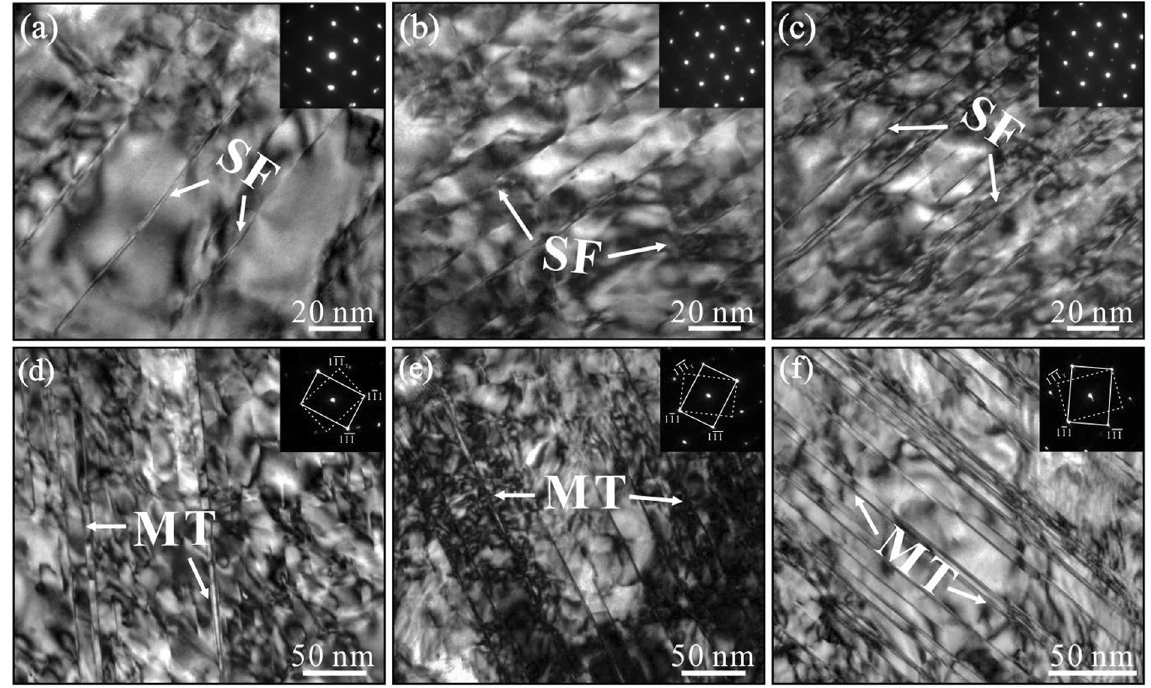
Figure 4. The typical microstructures in three superalloys after deformation at different temperatures. ( a ) 5Co alloy at 25 °C; ( b ) 15Co alloy at 25 °C; ( c ) 23Co alloy at 25 °C; ( d ) 5Co alloy at 725 °C; ( e ) 15Co alloy at 725 °C; ( f ) 23Co alloy at 725 °C, the insets at the top right corner of ( d ), ( e ) and ( f ) are the electron diffraction spots of MTs, SF denotes stacking fault and MT denotes microtwin.